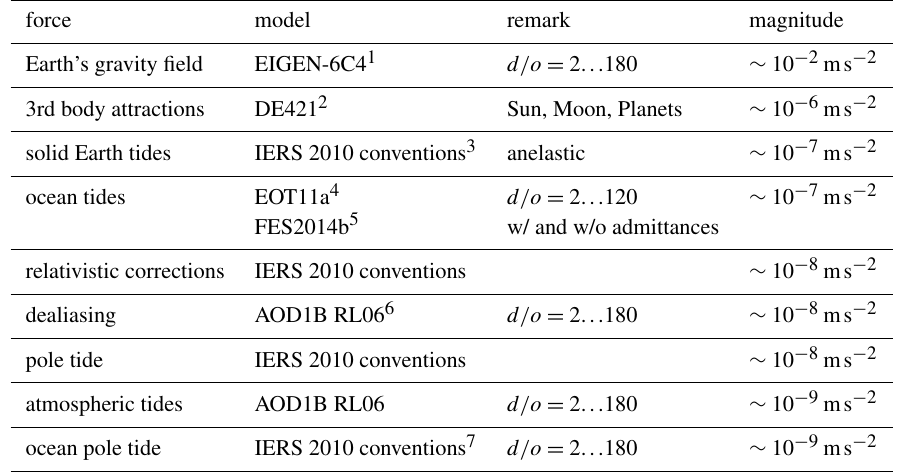
Table 1. Accelerations modelled in the benchmark data set. The magnitude is a rough estimation for the given GRACE orbit, the list is ordered according to the magnitude of the forces.